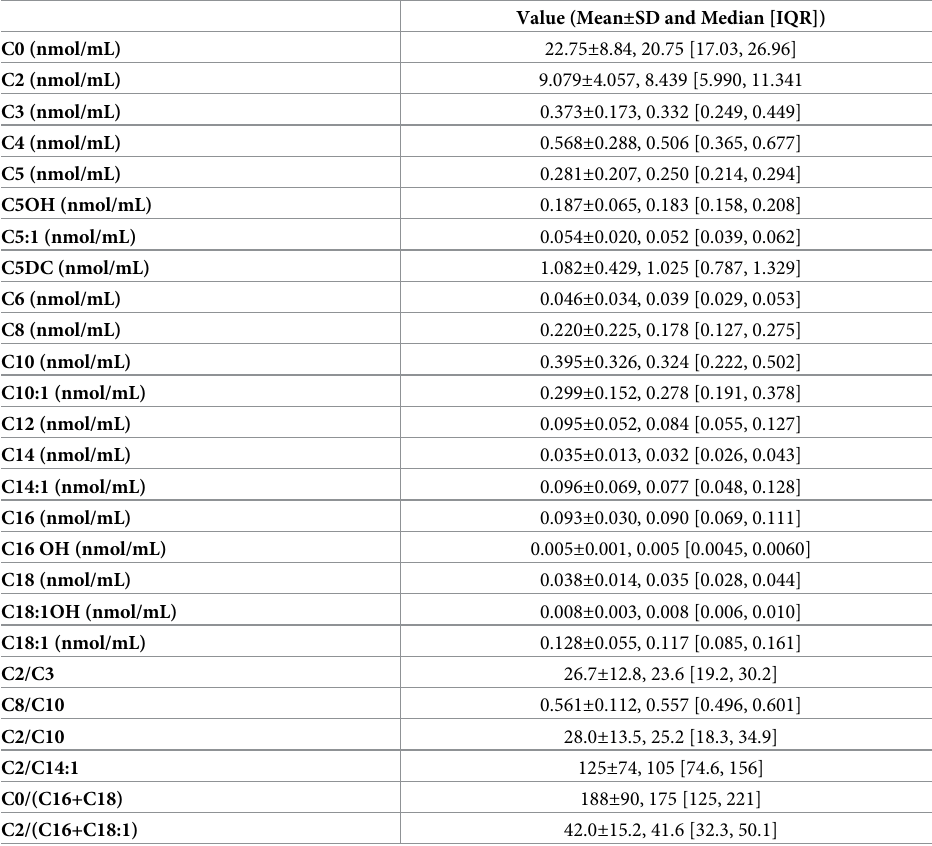
Table 2. Value of each carnitine moiety (n =